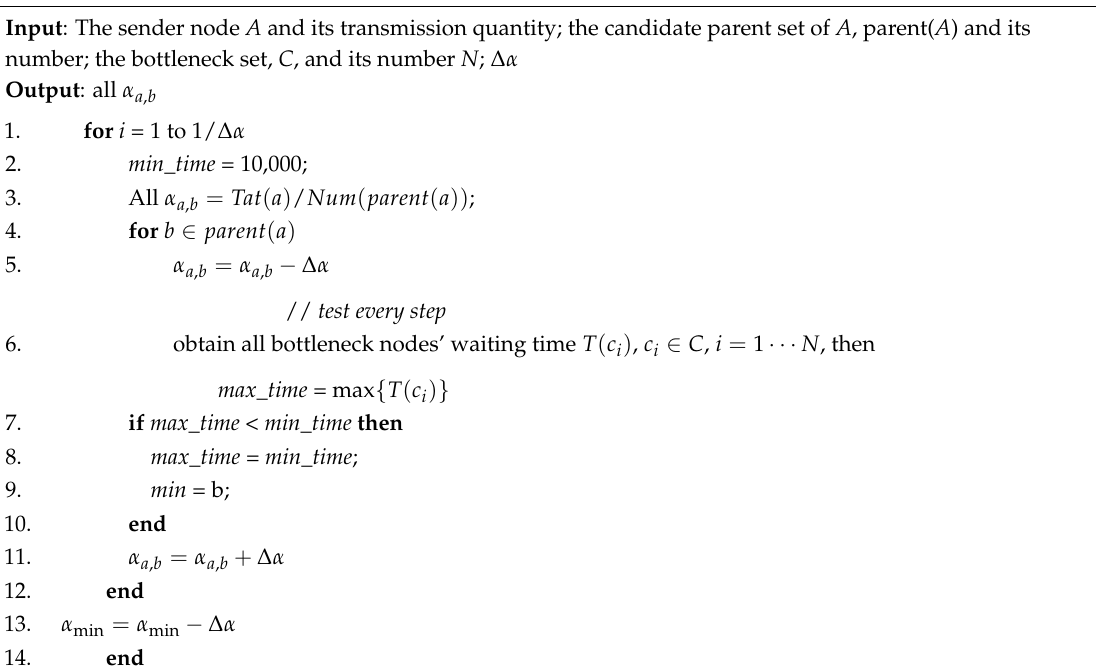
Algorithm 3 End-to-end delay based on multi-path